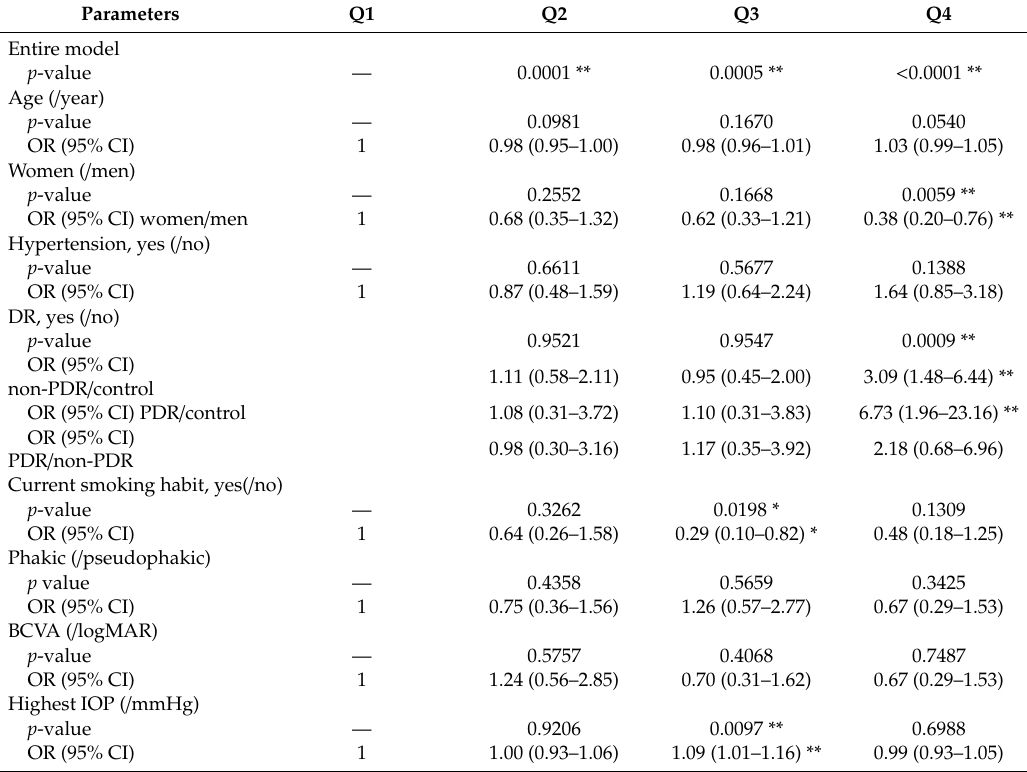
Table 3. Multivariate logistic regression analysis for comparisons among quartile AGEs